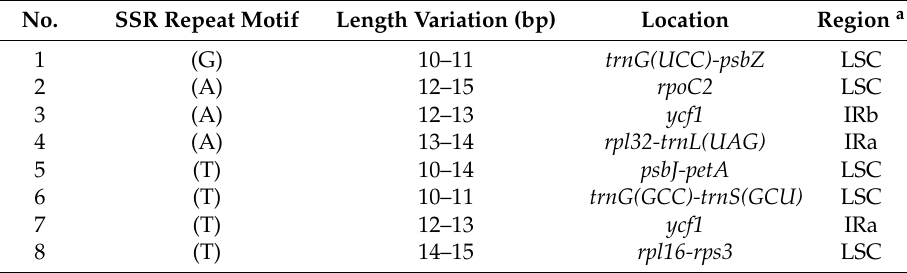
Table 4. The polymorphic chloroplast SSRs identified in Eucommia ulmoides .